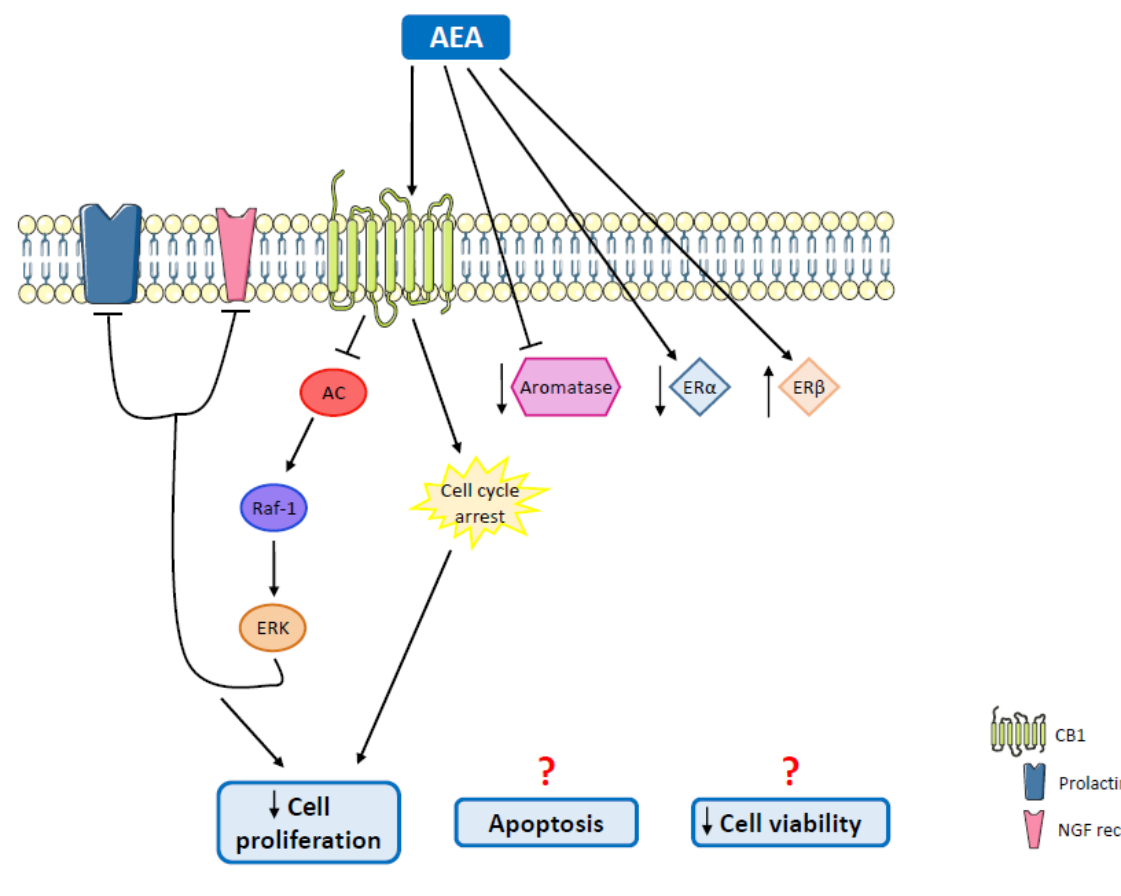
Figure 5. Antitumor effects mediated by AEA on ER + breast tumors. The sustained activation of the Raf-1/ERK pathway, as well as cell cycle arrest, reduces cell proliferation and survival. AEA is also able to inhibit aromatase function and decrease its protein levels, to downregulate ER α and upregulate ER β , inducing apoptosis and decreasing cell viability. AC: adenylyl cyclase; CB1: cannabinoid receptor 1; ER α : estrogen receptor α ; ER β : estrogen receptor β ; ERK: extracellular signal-regulated kinase; NGF: nerve growth factor; Raf-1: proto-oncogene Raf-1.